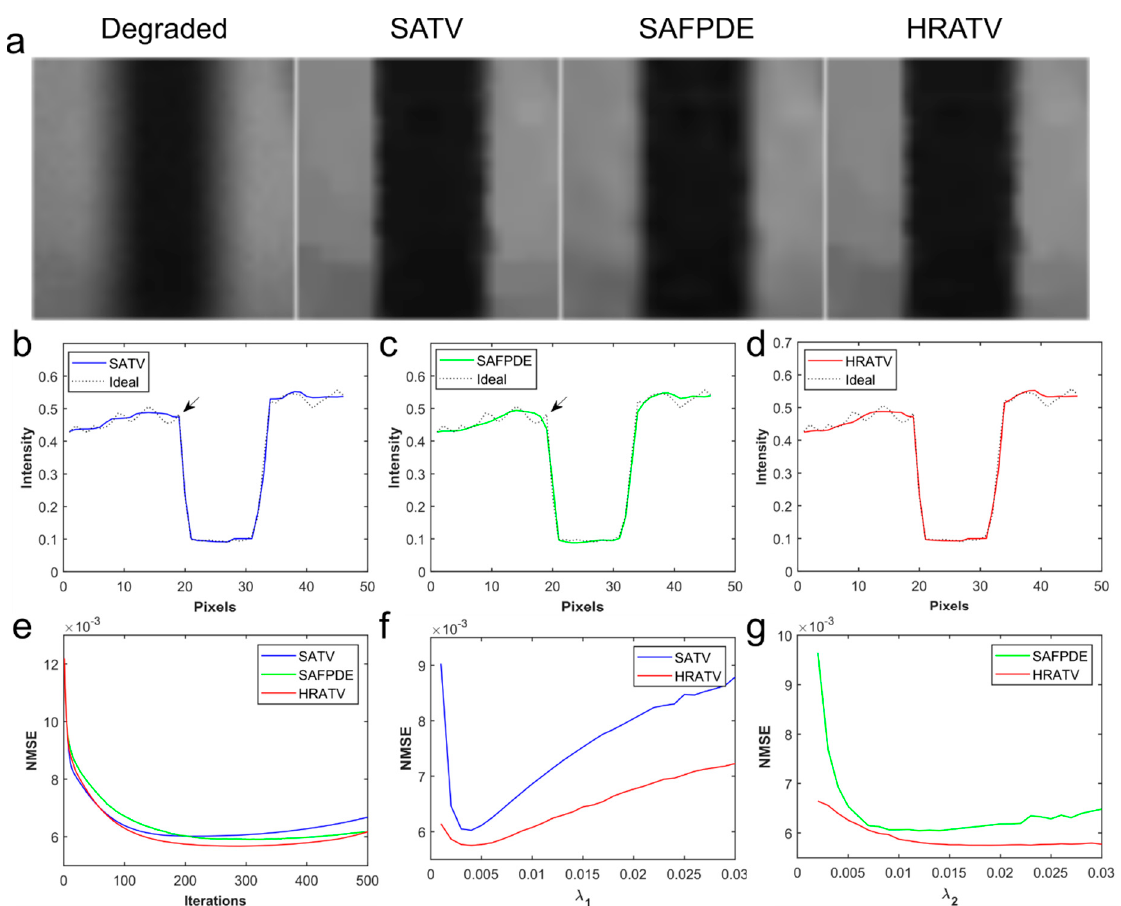
Figure 4. Edge preservation and parameter dependency of three deconvolution methods. ( a ) Degraded image and deconvolution results obtained by RLBD-SATV, RLBD-SAFPDE and RLBD-HRATV, respectively. ( b – d ) Line profiles crossing the desk leg. ( e ) Variations of NMSE during iterations. ( f , g ) Variations of NMSE as the parameter λ 1 or λ 2